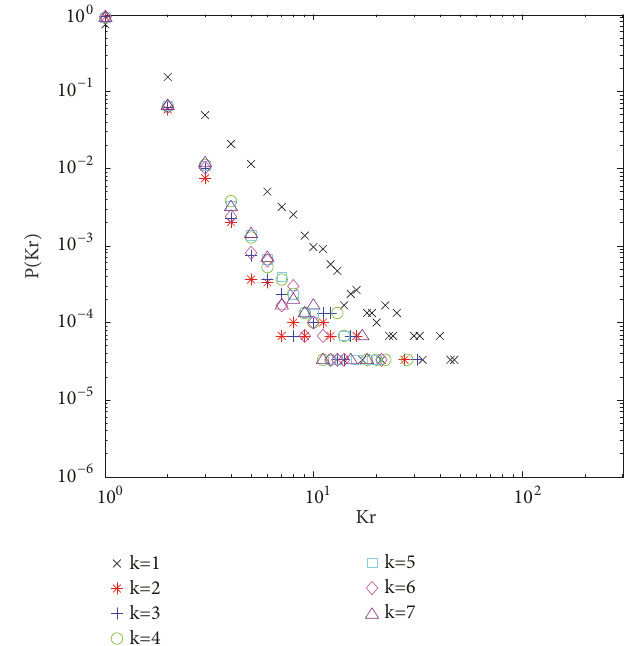
Figure 3: Hyperdegree distribution of different layers of hypernetwork